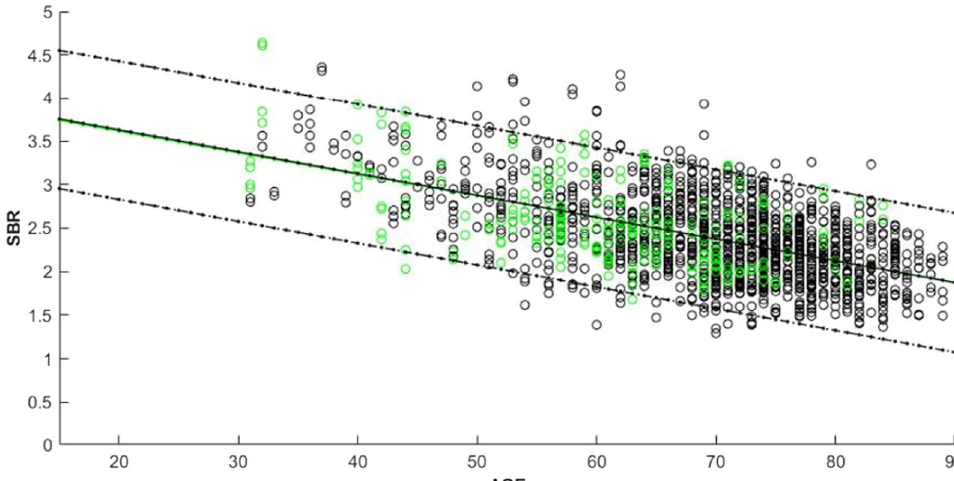
Fig. 3 Scatterplot of harmonized ScanOnlyDB striatum VOI Specific Binding Ratio (SBR) values ( black open circles ) and HvDB SBR values ( green open circles ) as a function of age. Linear regression lines for age: ScanOnlyDB ( green solid line ) and ScanOnlyDB